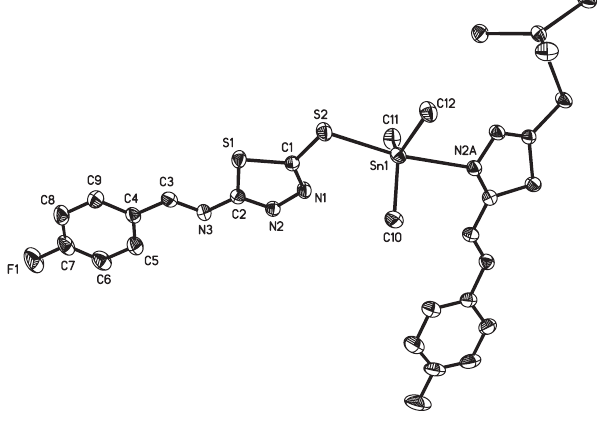
Table 2: Fractional atomic coordinates and isotropic or equivalent isotropic displacement parameters (Å 2